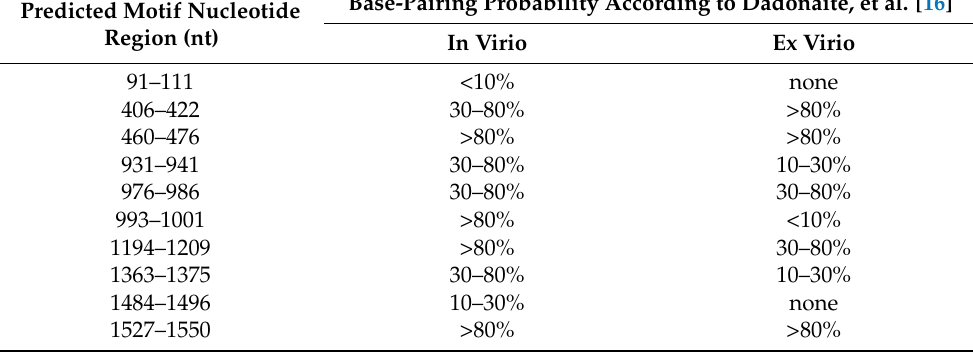
Table 1. Secondary structure motifs predicted in the in vitro mapping experiments of A/California/04/2009 (H1N1) and preserved according to in virio and ex virio mapping of A/WSN/1933 (H1N1). Base-Pairing Probability According to Dadonaite, et al. [16] Predicted Motif Nucleotide Region (nt) In Virio Ex